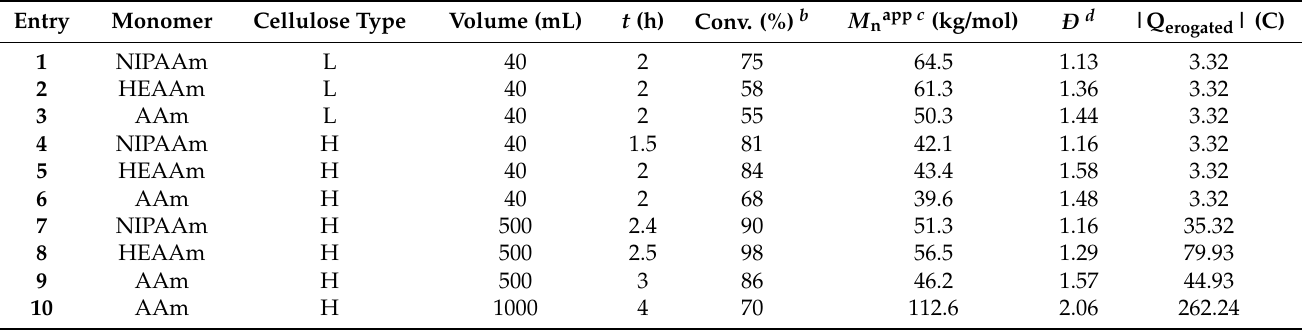
Table 5. Self-degassing galvanostatic se ATRP of AAm, HEAAm, and NIPAAm (all 10 wt%) starting from cellulose-BriB (H = high, M = medium) in the presence of 0.05 M SP as ROS scavenger and 0.05 M NaBr as supporting electrolyte inside SS304